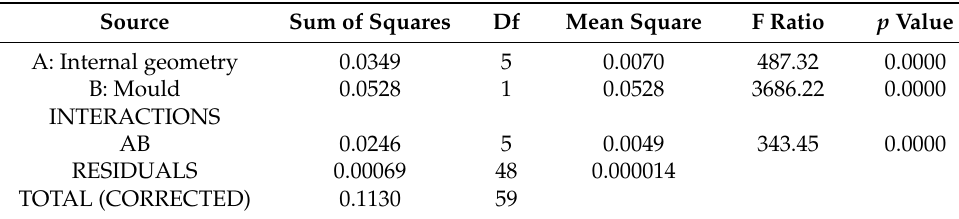
Table 5. ANOVA for ∆ L.